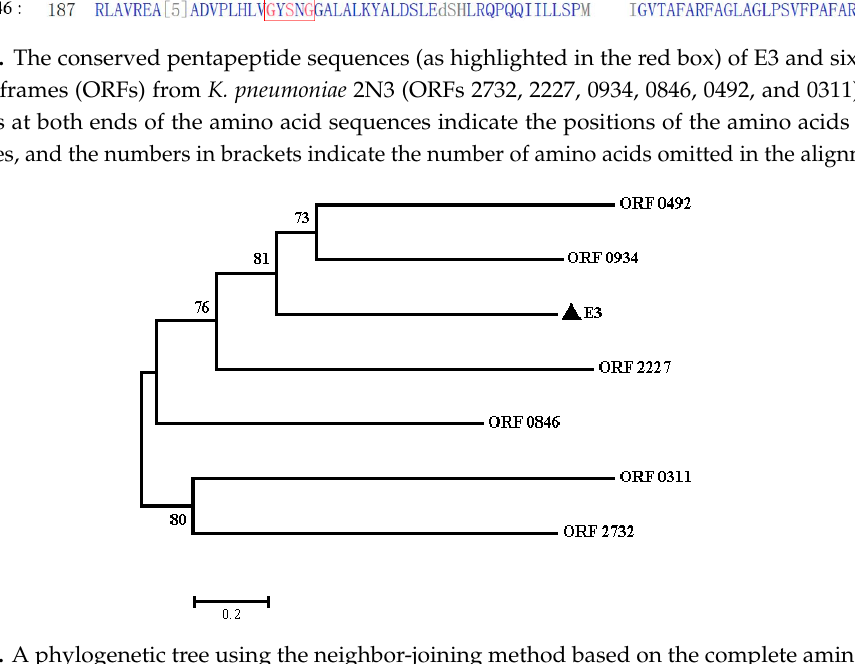
Figure 6. A phylogenetic tree using the neighbor-joining method based on the complete amino acid sequences of E3 (indicated with the symbol of a black triangle) and six ORFs from Klebsiella pneumoniae 2N3 (ORFs 2732, 2227, 0934, 0846, 0492, and 0311). Bootstrap values (given as 1–100%) derived from 1000 replicates are given next to the branches. The scale bar refers to the number of amino acid substitutions per site.